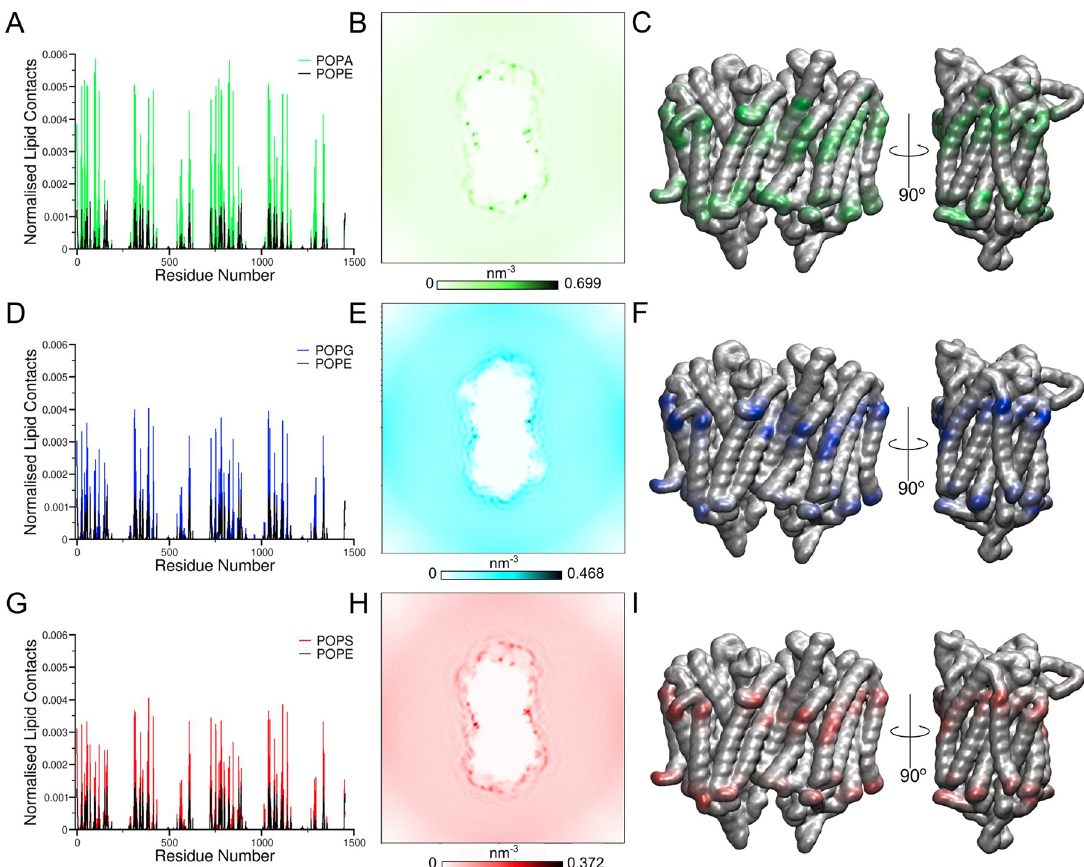
Fig 2. Tm -PPase interacts preferentially with anionic lipids at four distinct sites. The contacts between the lipid bilayer and Tm- PPase for model bilayers consisting of 80% POPE and 20% anionic lipid represented by A) normalised lipid contacts with both POPE and POPA/G/S and the residue number of the protein, B) the density of the PO4 bead of the CG anionic lipid around the protein, where the trajectory has been fitted to the protein backbone and C) the contacts of the PO4 atom represented on the 3D structure of the protein with a colour scale from white to green, for POPA, D-F) blue for POPG, and G-I) red for POPS. The lipid contacts were normalised by dividing the number of contacts of each residue with the length of simulation and the number of lipid